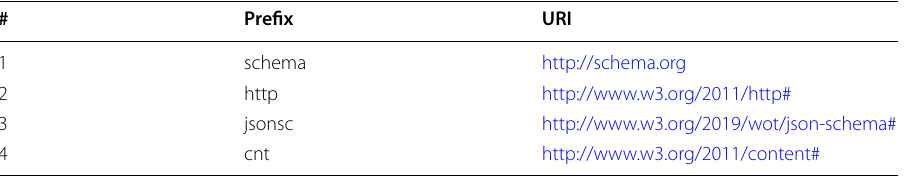
Table 1 List of adopted